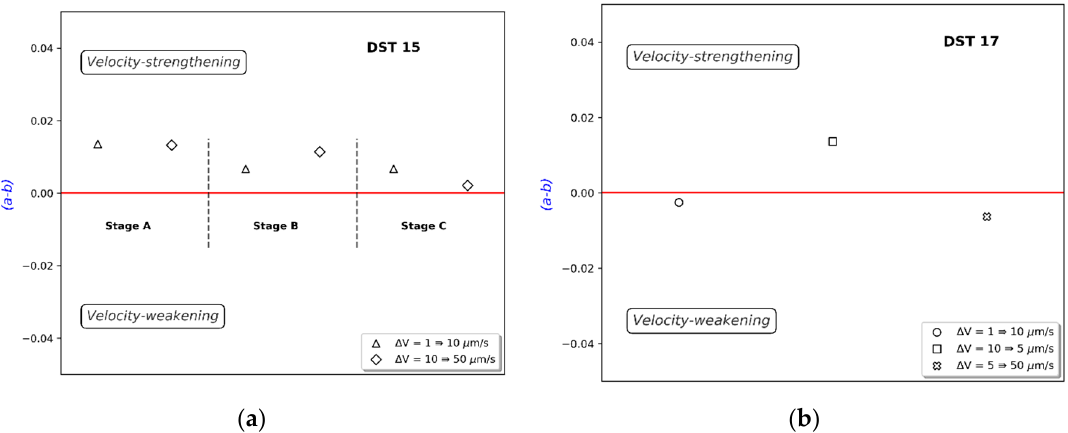
Figure 9. Friction rate parameter ( a − b ) for Draupne shale specimens showing the evolution of friction when a change of shear velocity is introduced. DST15 contains a pre-existing fault plane ( a ) and DST17 includes a laboratory-induced fracture ( b ). Negative values show velocity-weakening and thus imply potential for seismic slip, while positive values show velocity strengthening and potentially aseismic slip.